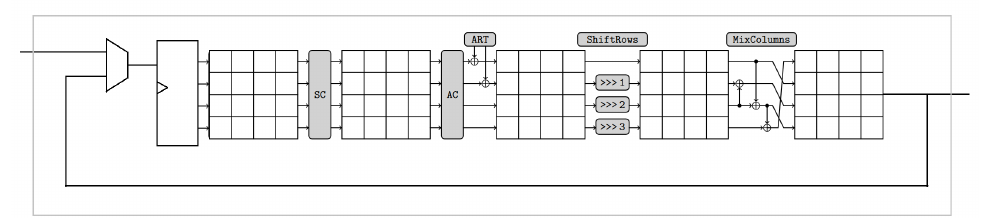
Figure 13: Exemplary depiction of a SKINNY hardware implementation (Partially copied from [BJK +